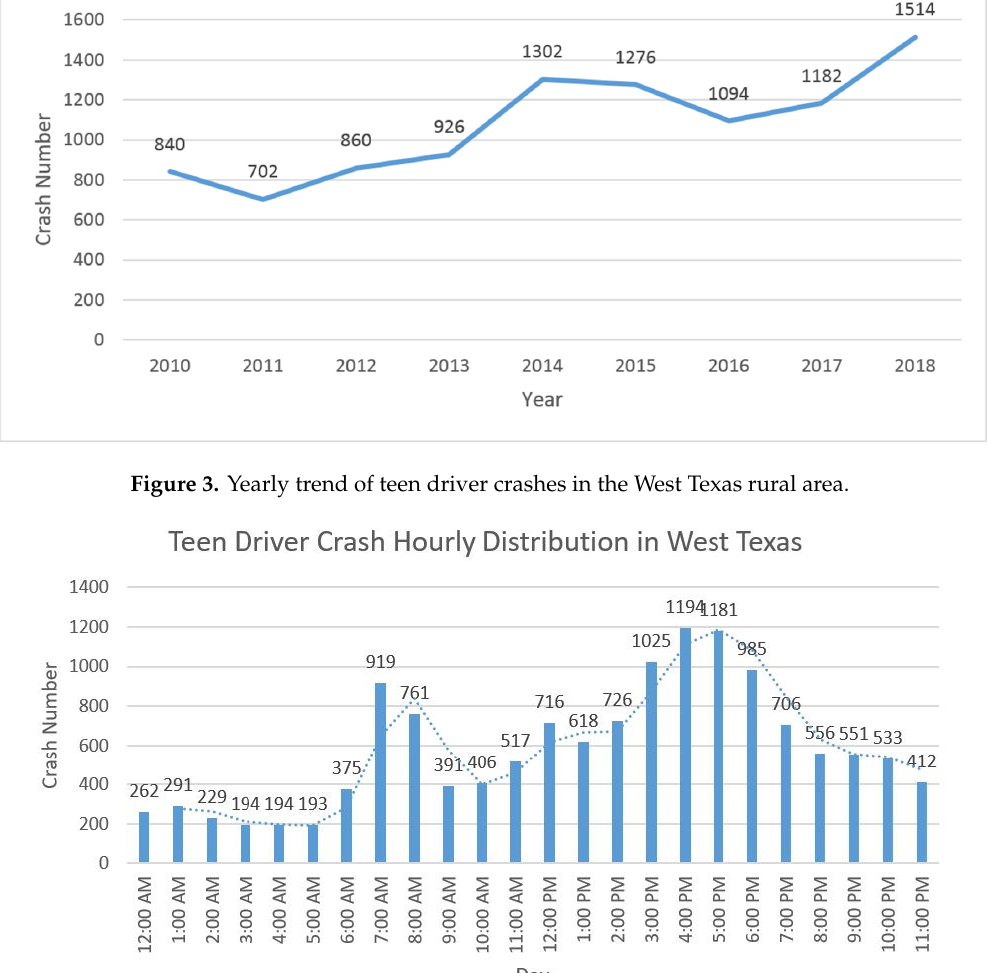
Figure 4. Hourly distribution of teen driver crashes in the West Texas rural area.